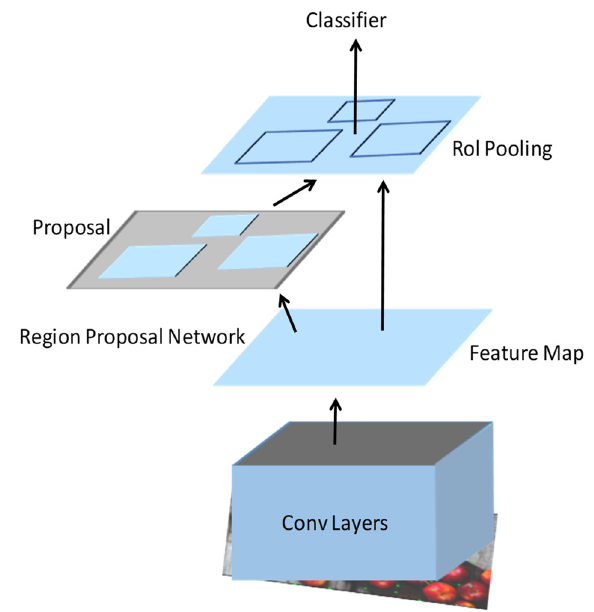
Figure 5. Running faster R-CNN on TensorFlow.